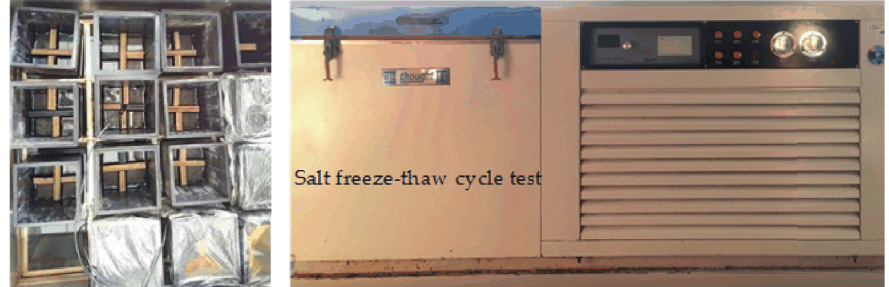
Figure 4: Salt freeze-thaw cycles test of cement